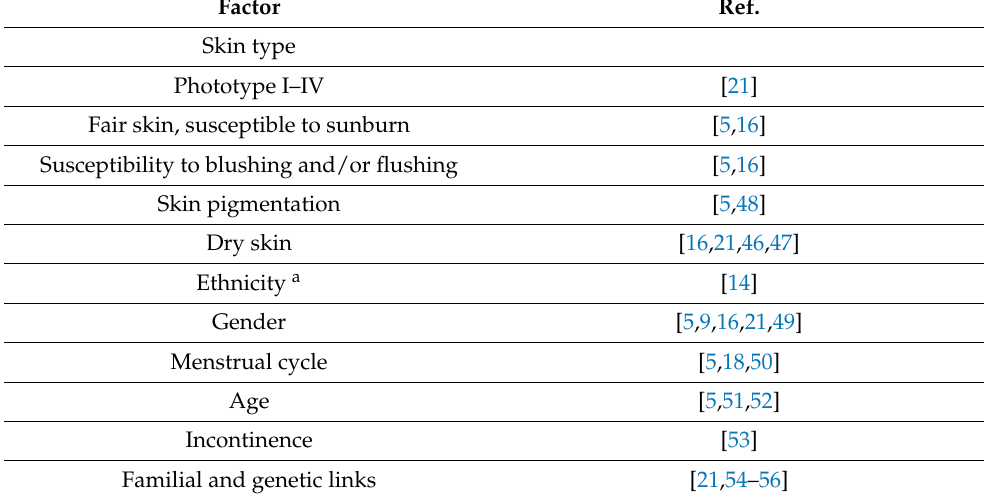
Table 2. Host factors associated with SSS.